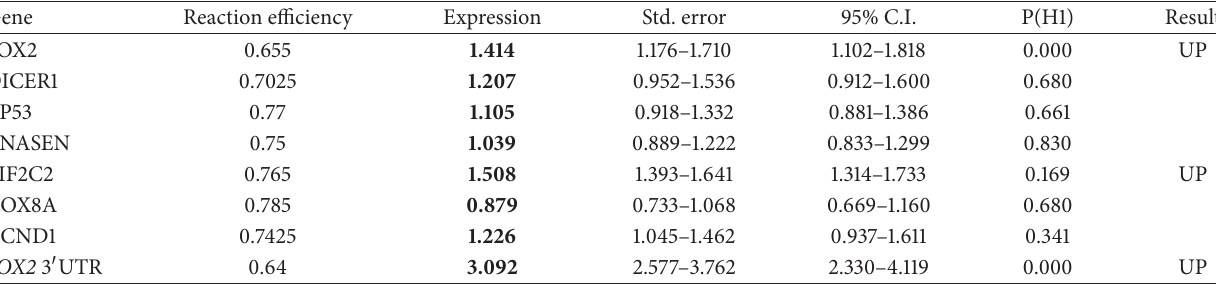
Table 8: Example of REST analysis on SOX2 and SOX2 ceRNAs levels of transcription quantified by RT-PCR compared to controls and normalized against 𝛽 -actin expression in SW1736 ATC cell line after SOX2 3 󸀠 UTR overexpression. P(H1) is the probability of the alternative hypothesis that the difference between sample and control groups is due only to chance.